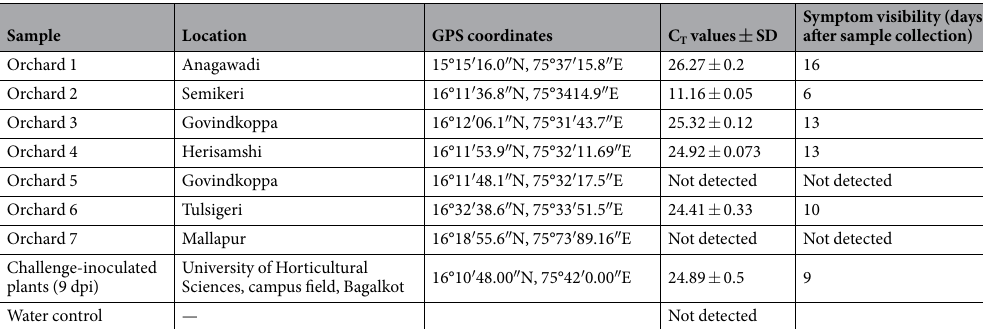
— Table 1. Diagnosis of bacterial blight using qPCR in field samples collected from pomegranate orchards in Karnataka, India, lacking disease